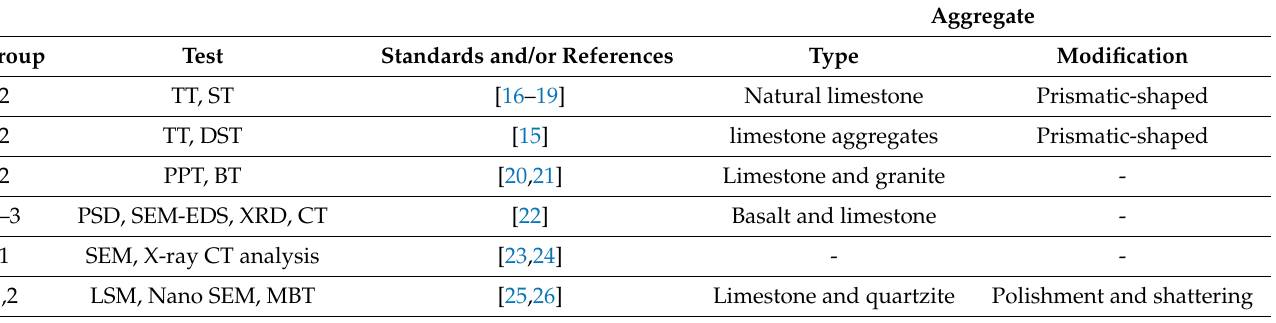
Table 1. Overview procedures used to analyze and evaluate the cement-based matrix-aggregate in- terfaces.